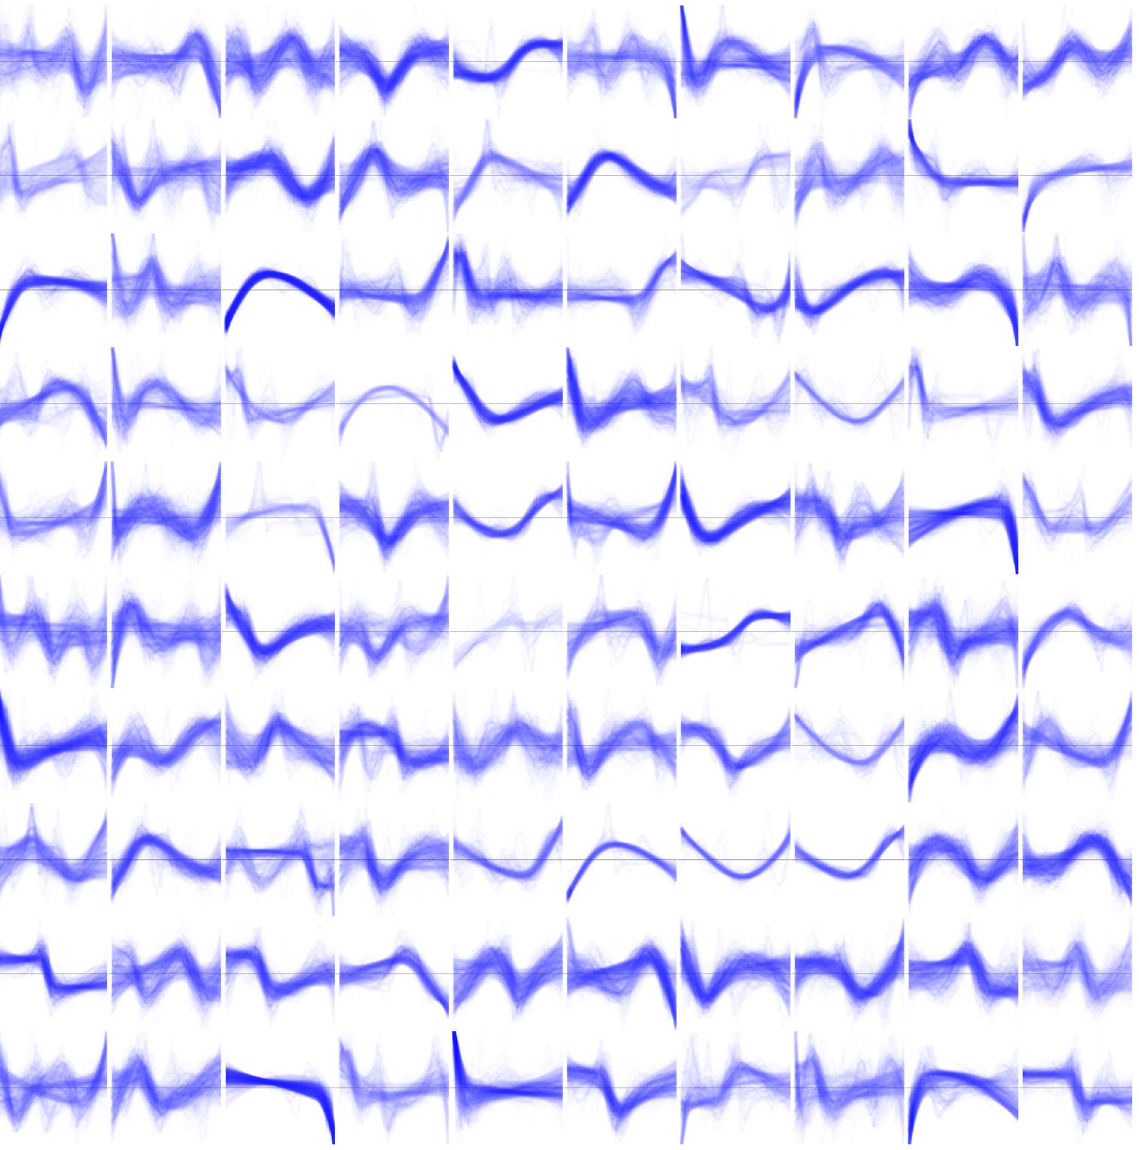
Figure 3. Second-layer learned features are complex nonlinear combinations of first-layer features. Because second layer features cannot be visualized directly, each feature in this set is represented as the confluence of the 100 input patches that most strongly activate the feature (those with the highest values of h i for feature i ).